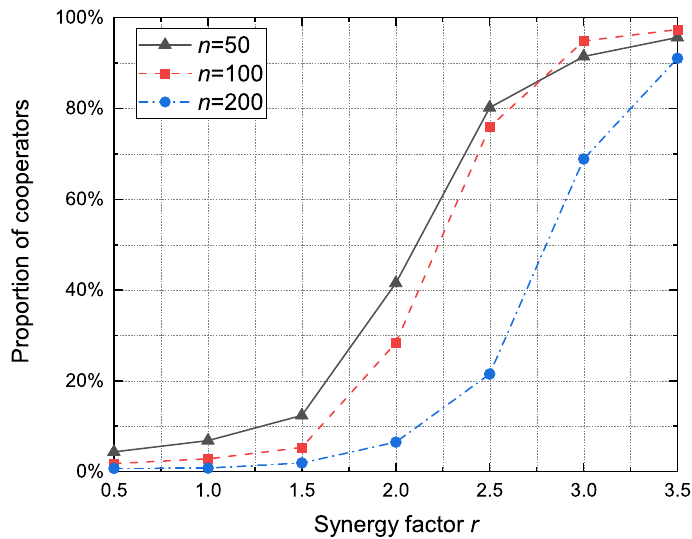
Figure 5. Comparison of the proportion of cooperators under different vehicle numbers for varying the synergy factor r